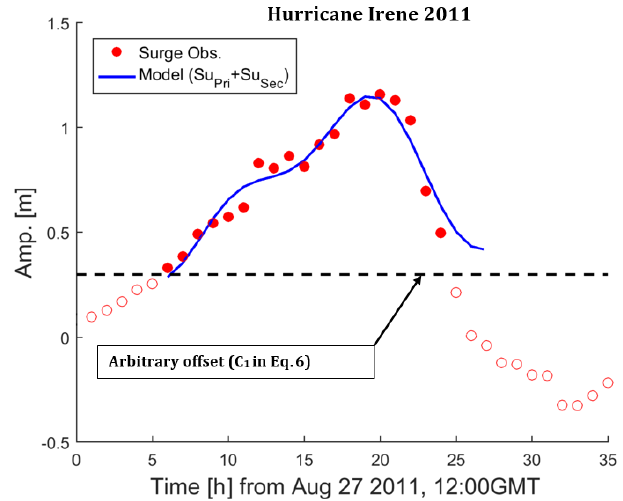
Figure 2. An example of decomposing surge into two sinusoidal waves. The red circles represent surge and are calculated by sub- tracting predicted tide from measured water level during Hurricane Irene (2011) at Lewes, DE (NOAA Station ID: 8557380). The blue line is the model fit that is the sum of Su Pri and Su Sec , and the dashed black line shows the threshold constant C 1 as in Eq.